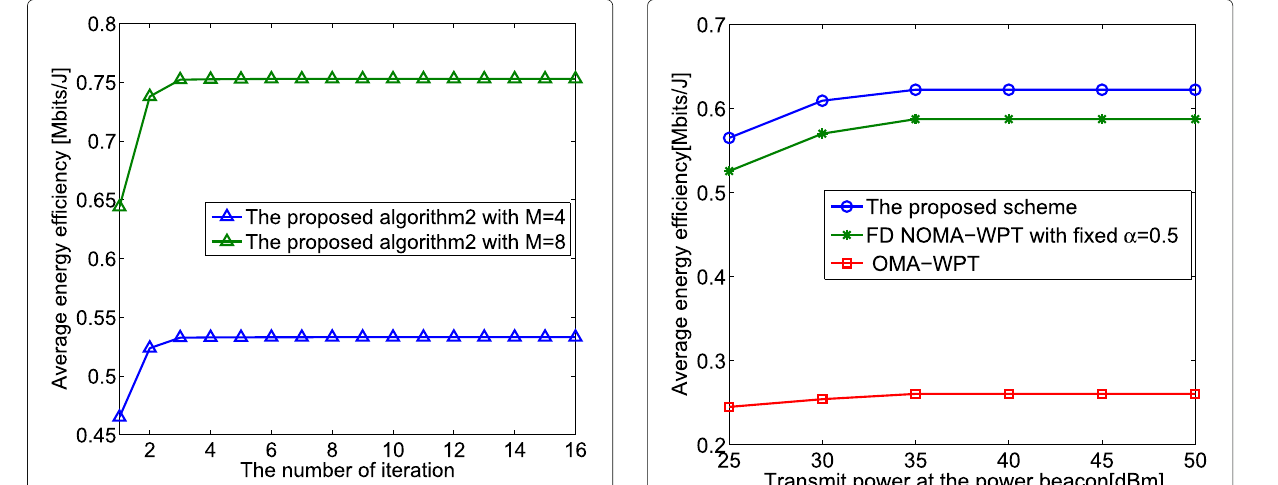
Fig. 6 The average energy efficiency versus transmit power at the power beacon